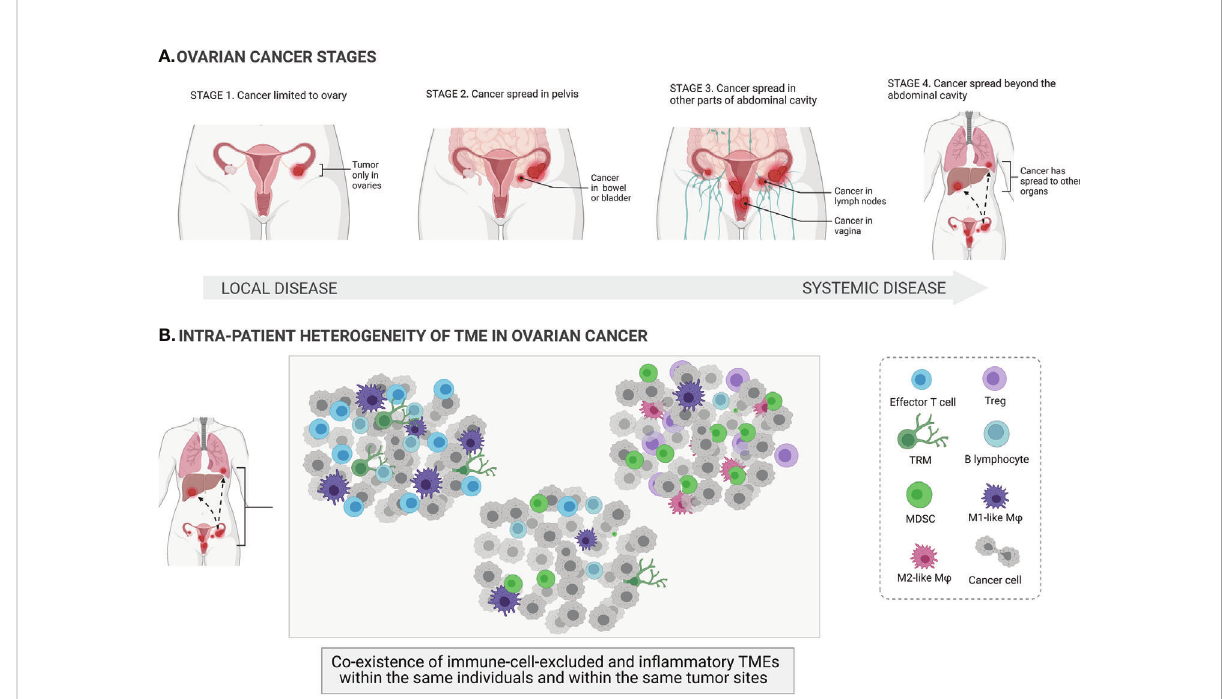
FIGURE 1 Ovarian cancer stages and heterogeneity of the tumor microenvironments. At its earliest stage (stage 1), the tumor (shown in the fi gure as red masses) is limited to one or both ovaries (local cancer in situ ) and the ovarian capsule is intact. Once the capsule is disrupted, the tumor spreads beyond the con fi nes of the ovaries (stages 2 – 4; systemic spread of cancer to other parts of organs) (A) . The tumor microenvironment (TME) of ovarian cancer involves a mixture of different immune cells, e.g., effector T cells, regulatory T cells (Tregs), tissue-resident memory T cells (TRM), B cells, macrophages (M j ), and myeloid-derived suppressor cells (MDSCs). Ovarian cancer is a highly heterogeneous disease, and different TMEs can coexist within the same individuals and within the same tumor sites (B)